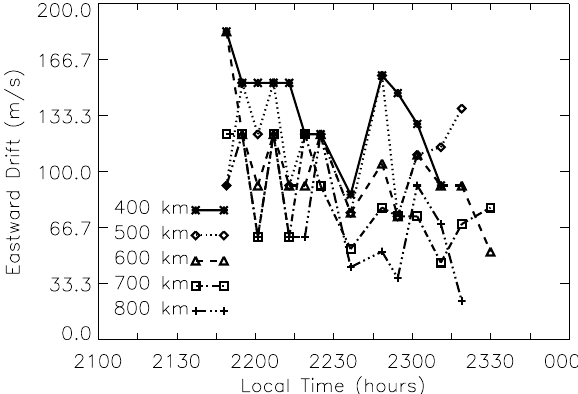
Fig. 6. Eastward drift velocity at different apex heights for the tilted depletion in the night of 4 March 2000 (panel c in Fig.